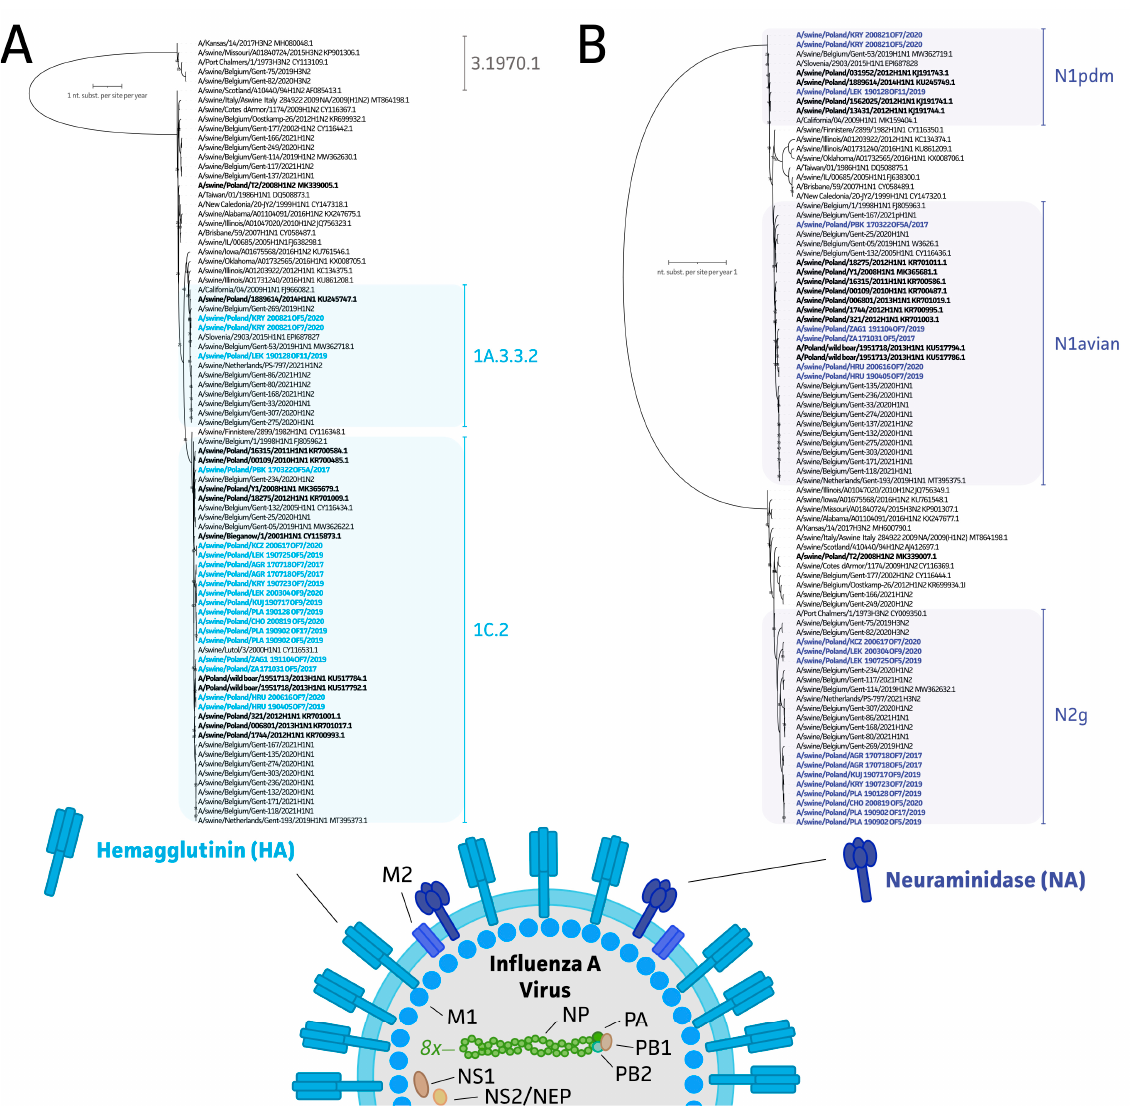
Figure 3. Maximum likelihood (ML) phylogenetic inference of swIAV hemagglutinin (HA) and neuraminidase (NA) gene segments. These are the surface glycoproteins of the swIAV virus particle as shown on the schematic representation of the IAV viral particle. ( A ) ML phylogenetic inference of the hemagglutinin gene segment with a representative European dataset to highlight the subclade classification of newly obtained Polish HA sequences (n = 19). Additionally, two HA sequences of near-complete genomes were included. HA classification based on the global H1 nomenclature system of Anderson et al. (2010). ( B ) NA-based phylogenetic inference to identify subclades of swIAV within the obtained Polish population (n = 19). Additionally, two NA sequences of near-complete genomes were included. Horizontal distances represent number of nucleotide substitutions per site per year. Only bootstrap values (1000 ultrafast UFBoot bootstraps) with less than 95% support are shown on the tree. Relevant swIAV strains were included in this tree, and available Polish strains and newly sequenced strains are highlighted in black and blue/purple, respectively.